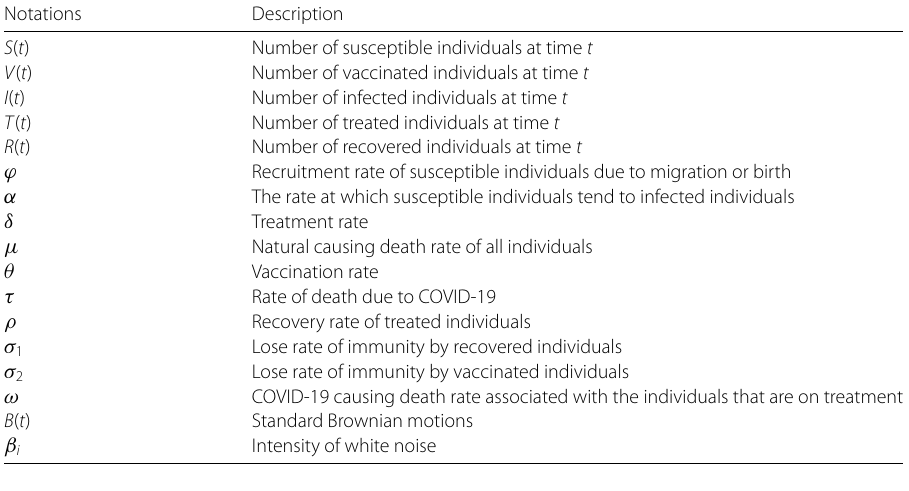
Table 1 Description of state variables and parameters